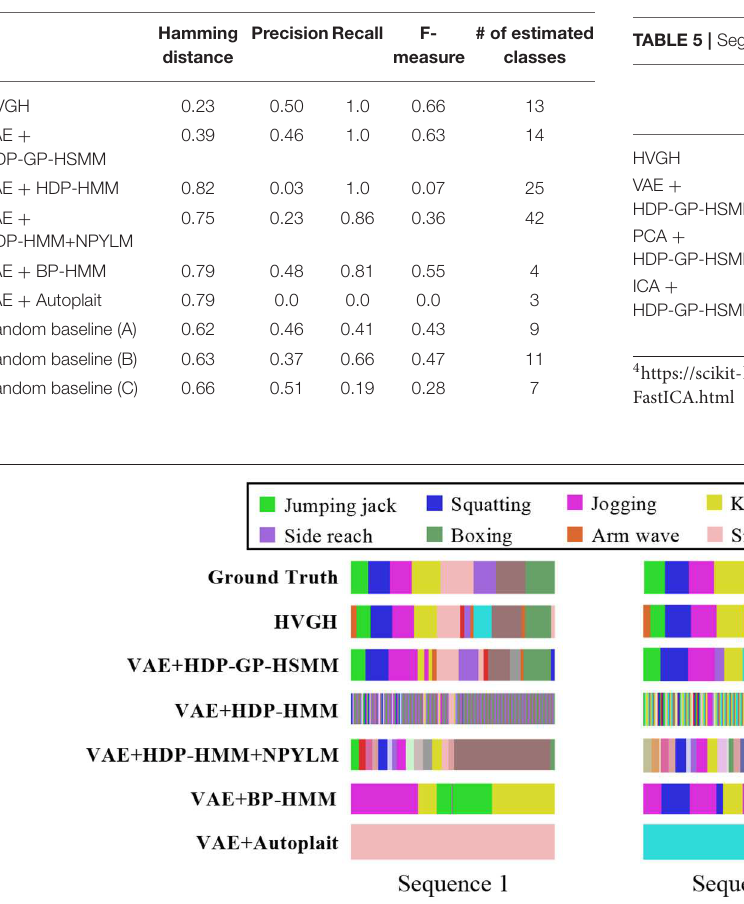
TABLE 4 | Segmentation results for the exercise motion 2: subject 14.